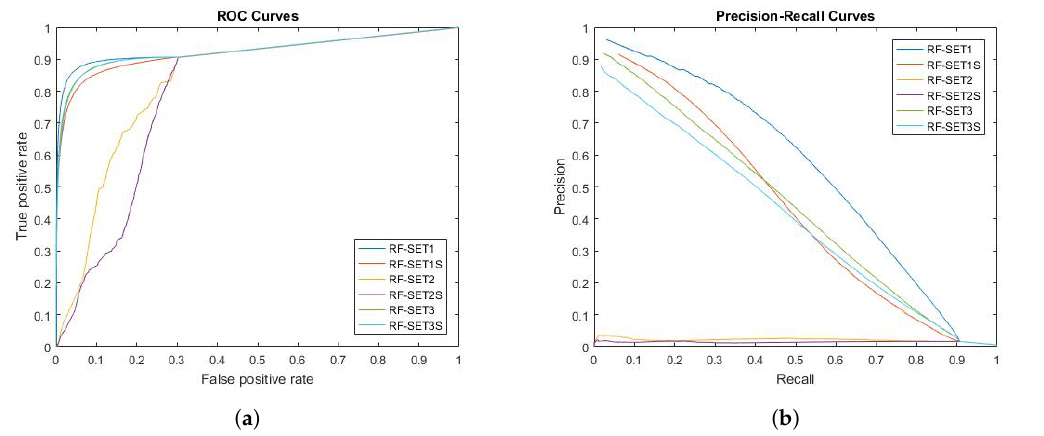
Figure 5. Receiver operating characteristic (ROC) curve and precision-recall curve of RF for all evaluated voxels. Six different ways of extracting features from MRI are tested and evaluated in this experiment. ( a ) ROC curve of RF; ( b ) Precision-recall curve of RF.